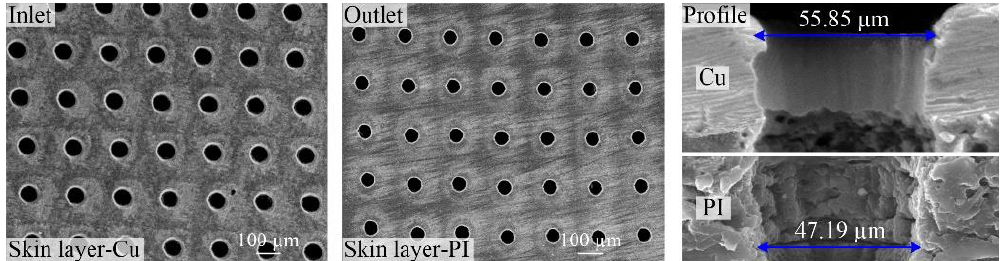
Figure 11. SEM images of through-holes and cross-sections in single-sided board.